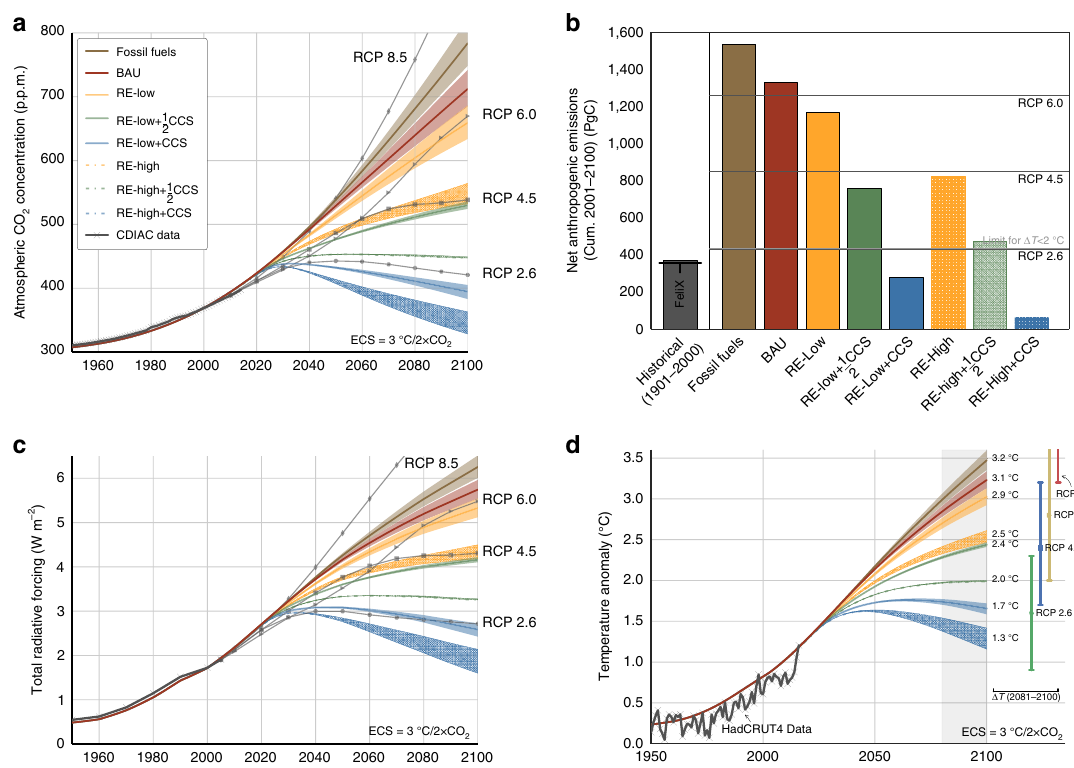
Figure 6 | Global carbon-climate indicators. ( a ) Atmospheric carbon concentration (p.p.m.), shown with CDIAC data 33 and RCP projections 7 ; ( b ) cumulative anthropogenic emissions (2001–2100) [PgC], compared with historical emissions (IPCC 3 and FeliX) and RCP projections. ( c ) Total radiative forcing (Wm (cid:2) 2 ) for all greenhouse gases, shown with CDIAC data and RCP projections. CO 2 forcing is modelled endogenously; all other greenhouse gases are exogenously set to RCP 4.5. ( d ) Global average surface temperature change relative to preindustrial ( D T ) ( (cid:2) C). Historical time series from HadCRUT4 (ref. 38). D T projections associated with each of the RCPs in 2100 are shown at right with 90% confidence intervals 40